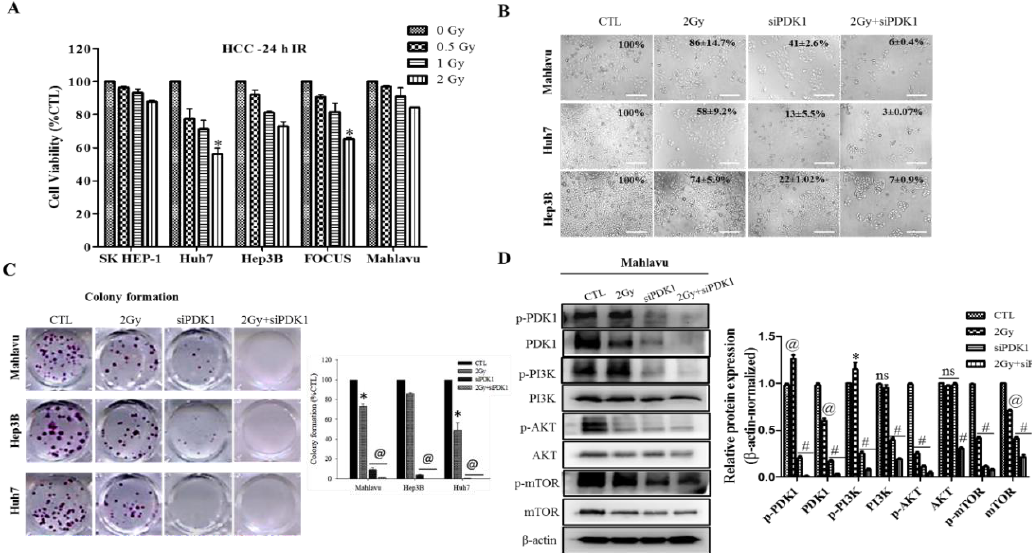
Figure 2. Altered PDK1 expression is enough for the deactivation of the PI3K/PDK/AKT/mTOR oncogenic signaling and sensitizes aggressive HCC cells to radiotherapy. ( A ) Histograms of the effect of 24 h exposure to 0.5 – 2 Gy IR on the viability of SK-HEP1, Huh7, Hep3B, CVCL_7955 or Mahlavu cell lines. ( B ) Representative photo-images of the effect of 2 Gy, siPDK1 or 2 Gy+siPDK1 on the viability/proliferation, and morphology of Mahlavu, Huh7 or Hep3B cells. Scale bar: 100 μ m, 10× objective. ( C ) Representative photo-images showing the effect of 2 Gy or siPDK1 on clonogenicity of Mahlavu, Huh7 or Hep3B cells. Scale bar: 100 μ m, 10× objective. ( D ) Representative western blot images and histograms showing the effect of 2 Gy, siPDK1 or 2 Gy+siPDK1 on the expression levels of p-PI3K p85 (Tyr458)/p55 (Tyr199), PI3K, p-PDK1 (Ser 241), PDK1, p-AKT (Ser 473), AKT, p-mTOR (Ser 2448) and mTOR proteins in Mahlavu cells. * p < 0.05, @ p < 0.01, # p < 0.001 vs. CTL; ns, not